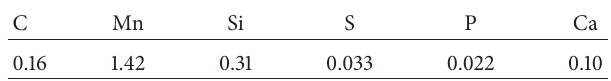
Table 2: Chemical properties of 16Mn